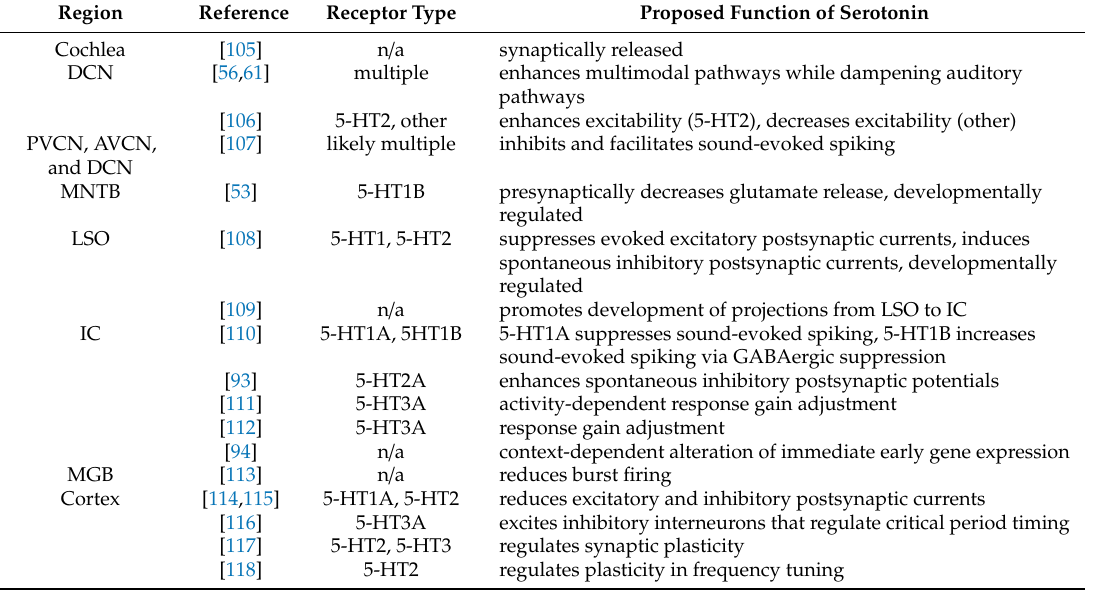
Table 1. Selected articles describing some of the functional e ff ects of serotonin across a range of auditory sites. Abbreviations: DCN = dorsal cochlear nucleus; AVCN = anteroventral cochlear nucleus; PVCN = posteroventral cochlear nucleus; MNTB = medial nucleus of the trapezoid body; LSO = lateral superior olive; IC = inferior colliculus; MGB = medial geniculate